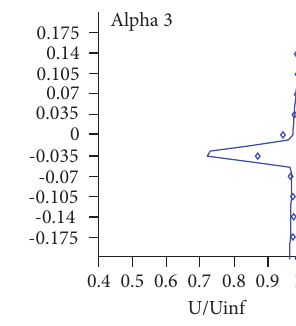
Figure 21. Streamwise velocity profile at x/c = 0.25, Mach = 0.4.